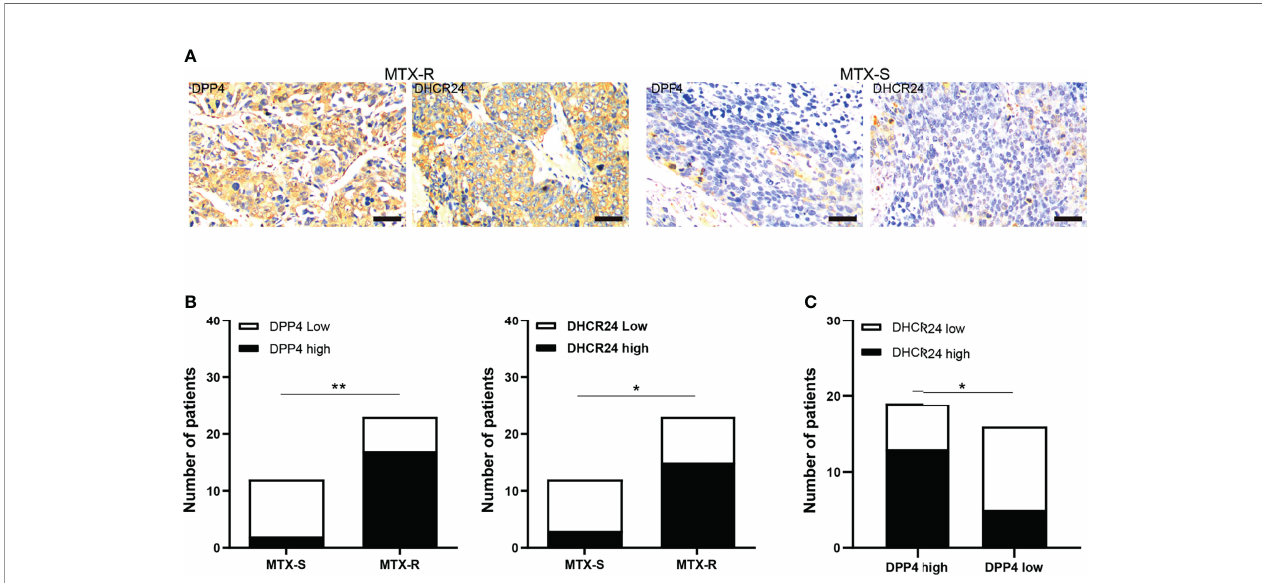
FIGURE 6 | DPP4/DHCR24 signaling is highly activated in MTX-resistant GTN specimens. (A) Immunostaining of DPP4 and DHCR24 in clinical GTN samples. Representative IHC staining micrographs were shown for MTX-resistant (left panel) or MTX-sensitive (right panel) GTNs. Bars: 100 µm. (B) DPP4 and DHCR24 were highly expressed in MTX-resistant clinical GTN samples. *P<0.05, as compared with MTX-sensitive GTNs. (C) High expression of DPP4 was signi fi cantly correlated with high expression of DHCR24 in GTNs. *P < 0.05, **P < 0.01, as compared with DPP4-high